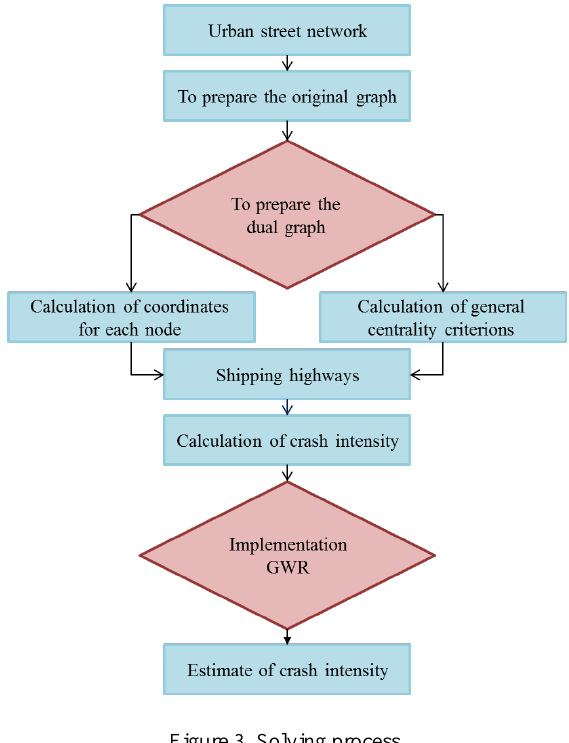
Figure 3. Solving